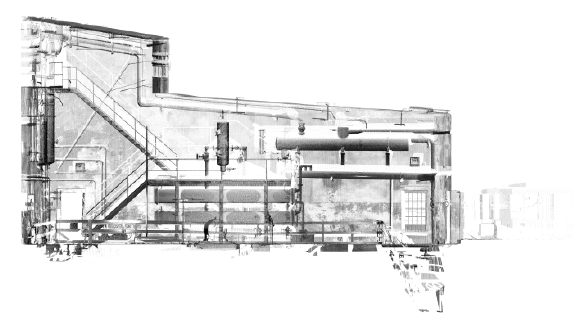
Figure 15. Virtual scan of the west wall of the machine room with piping, machinery and structures that could be mapped.